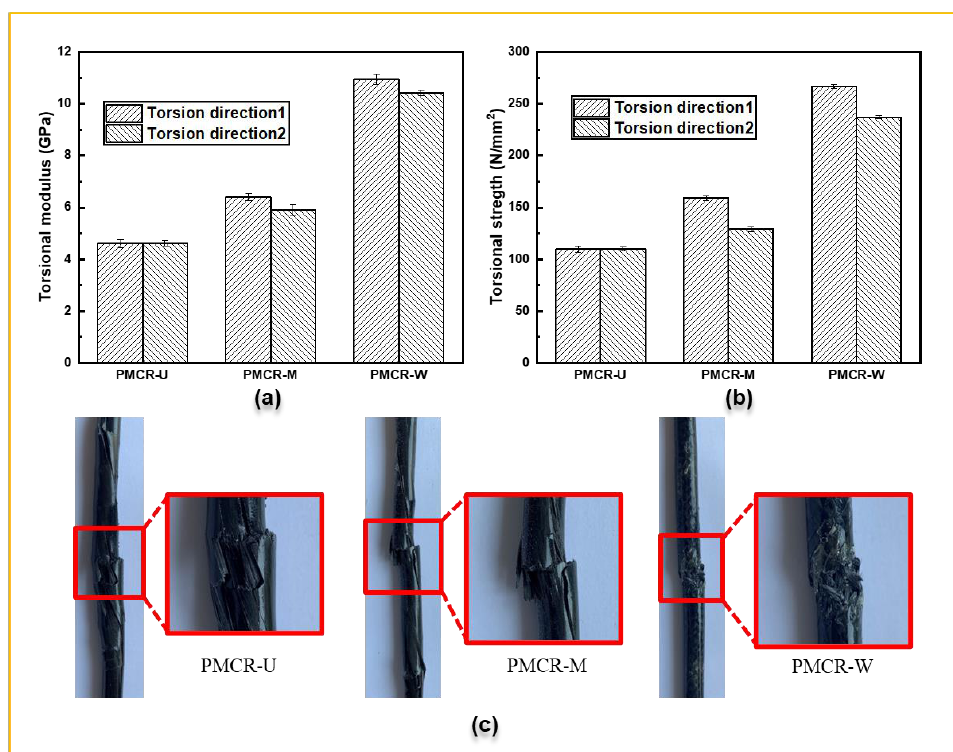
Figure 4. ( a ) Torsional modulus and ( b ) torsional strength of PMCRs with different torsional directions, i.e., torsional direction 1 (the torsion direction was the same as that of the twist direction of reinforcement) and torsional direction 2 (the torsion direction was opposite to that of the twist direction of reinforcement), and ( c ) failure topographies of PMCRs.